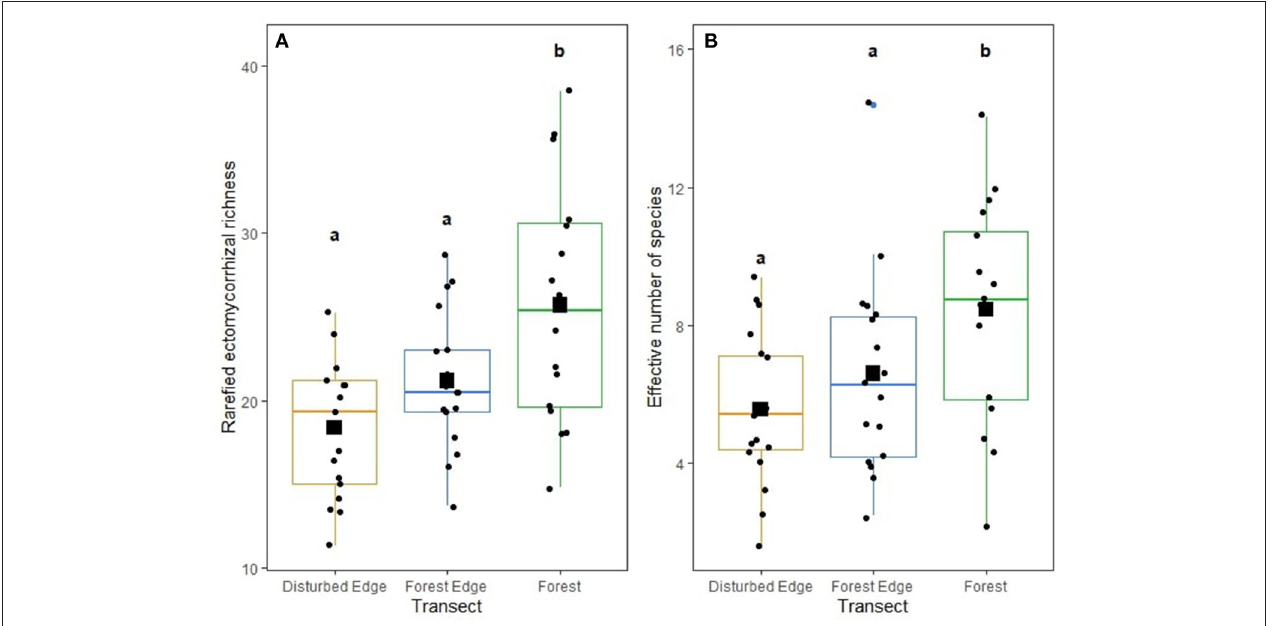
FIGURE 3 | (A) Rarefied ectomycorrhizal (ECM) fungal richness and (B) effective number of species (exponent of Shannon diversity) of ectomycorrhizal (ECM) fungi across the disturbance gradient: disturbed edge [i.e., remnant stand of Corymbia calophylla bordering a road with anthropogenic disturbance (agriculture, horticulture, viticulture or grazing)], forest edge, and 200m within a forest. For each boxplot, the median value is represented by a horizontal line, the first and third quartiles by boxes and values outside the quartiles by whiskers. Outliers are values > 1.5 times the interquartile range. Squares indicate mean values and circles indicate range of data. Lower case letters that differ are significantly ( p < 0.003) different from each